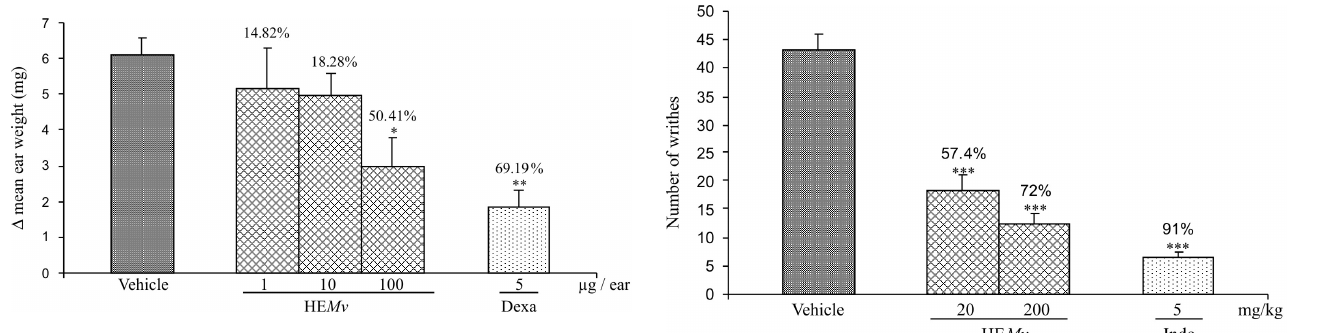
FIGURE 4 - Effect of hydroethanolic extract of M. velame in hostacerin ® on croton oil-induced cutaneous dermatitis in mice. Each value is the mean ± S.E.M. of 7-8 rats. *p<0.05 and **p<0.01 compared with control. One-way ANOVA followed by Student-Newman–Keuls.